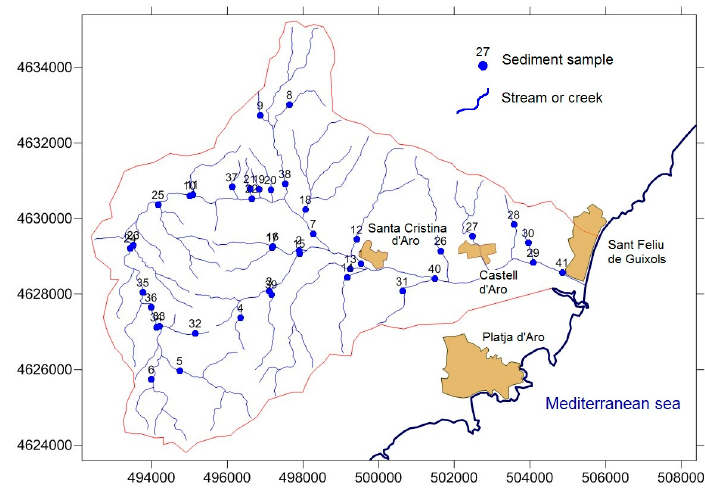
Figure 3. Location of sediment samples.